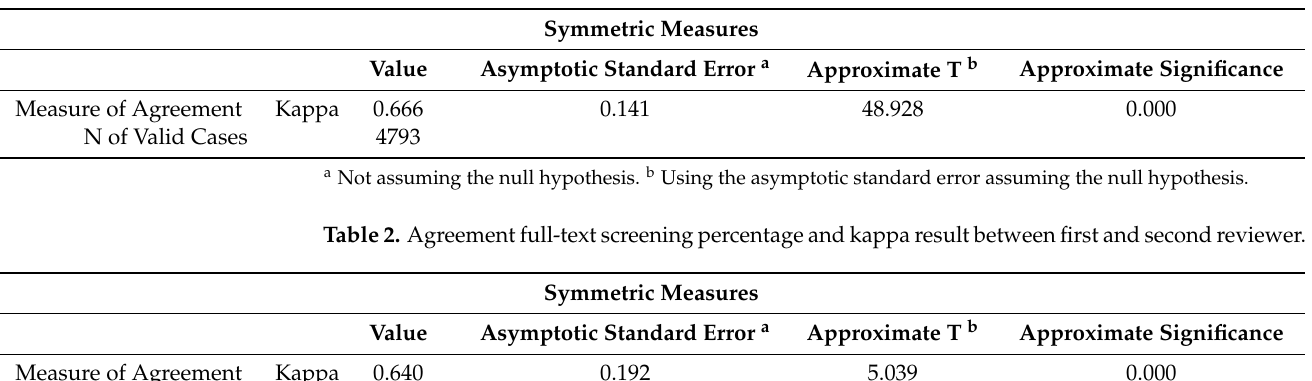
Table 1. Agreement title and abstract screening percentage and kappa result between first and second reviewer.